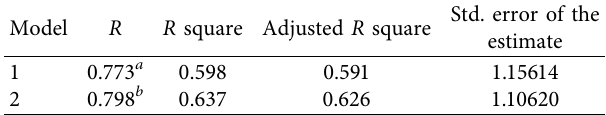
Table 7: Model summary for leadership skills, stakeholder man- agement, project scope, and execution of fibre optic infrastructure. Model R R square Adjusted R square